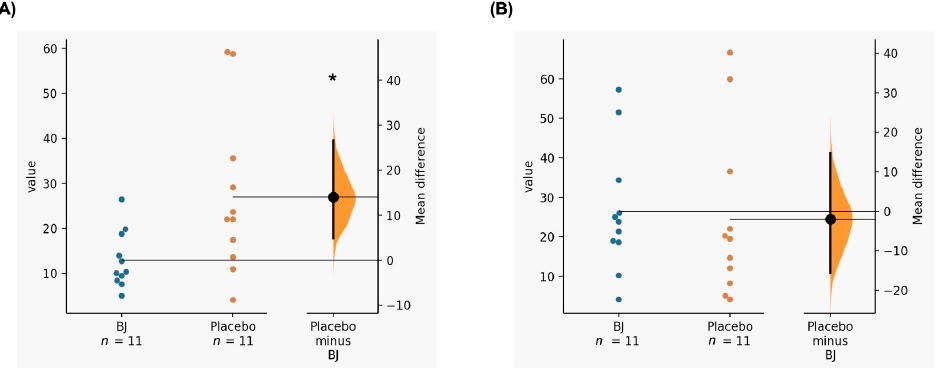
Figure 2. ( A ) Acute effects of BJ consumption compared to placebo on RMSSD during exercise; ( B ) Acute effects of BJ consumption compared to placebo on post-exercise RMSSD. BJ: beetroot juice. *: Significant differences ( p -Value <